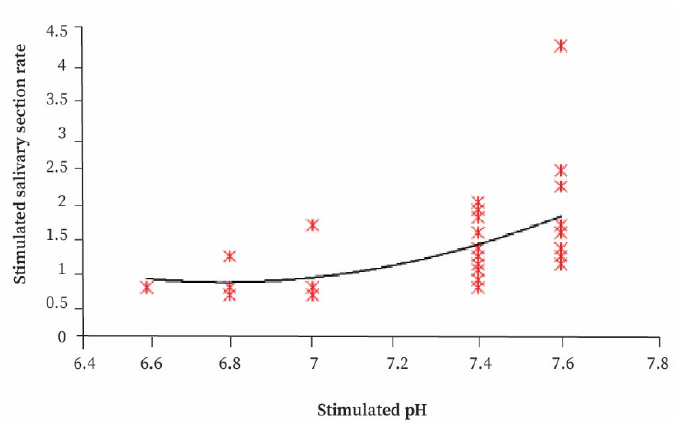
Figure 6. Dependence of the ratio of stimulated salivary secretion (ml/min) on the stimulated pH.